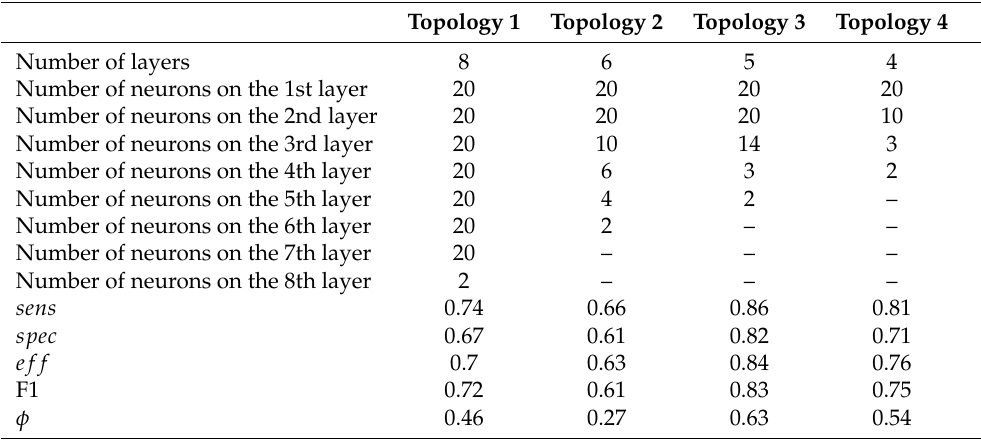
Table 3. Binary classification results for artificial neural networks with different fully connected layer